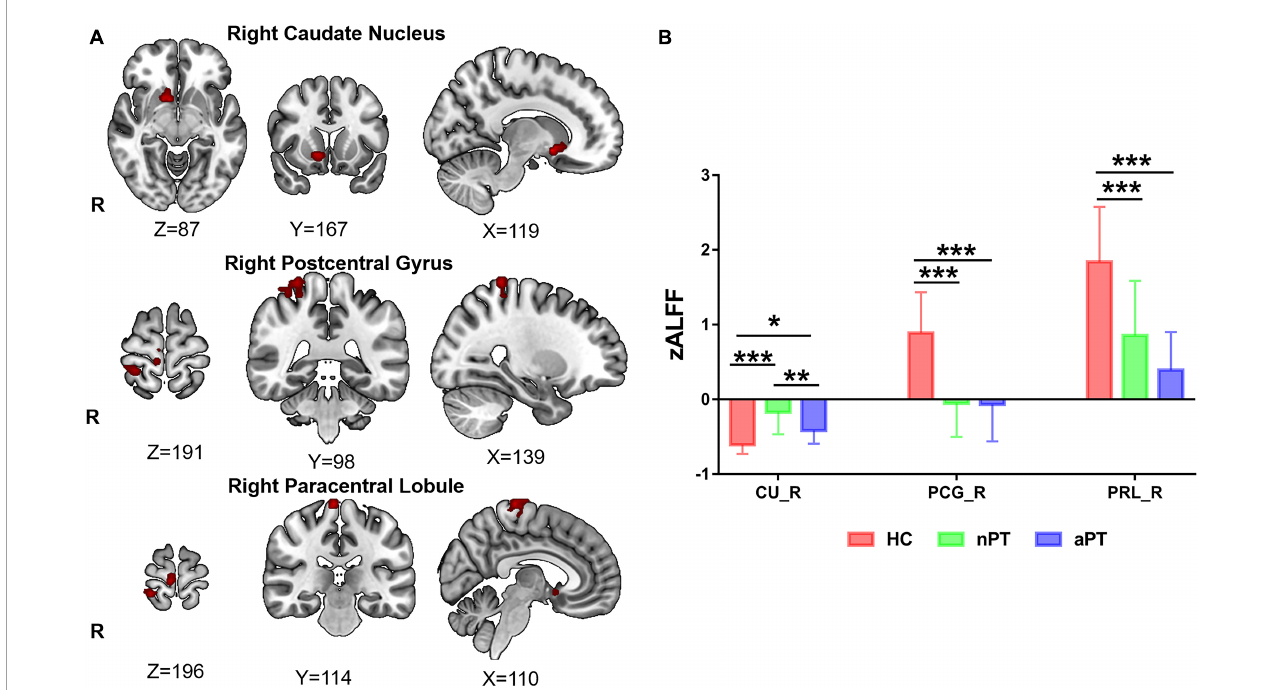
FIGURE1 z-score transformation amplitude of low-frequency fluctuations (zALFF) differences between HC, nPT, and aPT groups. (A) The right caudate nucleus, right postcentral gyrus, and right paracentral lobule were the significantly different brain regions among the three groups. (B) The zALFF values of these significantly different brain regions were extracted and analyzed by one-way analysis of variance (ANOVA) with Bonferroni post-hoc test. The caudate zALFF in aPT was higher than that in HC, and lower than that in nPT. The zALFF of the right postcentral gyrus and paracentral lobule in HC was higher than those of aPT and nPT. CU, caudate nucleus; PCG, postcentral gyrus, PRL, paracentral lobule; HC, healthy control; nPT, normal gait patients; aPT, abnormal gait patients. * P < 0.05; ** P < 0.01; *** P < 0.001.